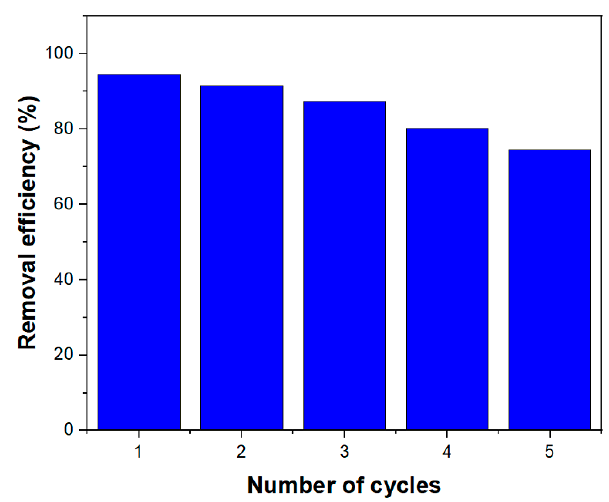
Figure 9. Reusability of MIL-100(Fe) @Fe 3 O 4 @AC after five cycles. (C 0 = 100 mg/L, sorbent dosage = 0.25 g/L, and temperature = 295 K).